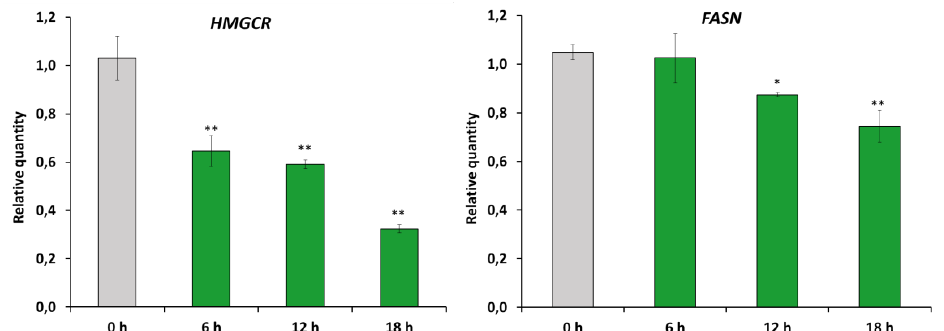
Figure 4. RM-581 affects lipid biosynthesis. mRNA expressions of HMGCR and FASN in PC-3 cells treated with RM-581 (5 µ M) at 6, 12, and 18 h post-treatment. * p < 0.05, ** p < 0.01 vs. 0